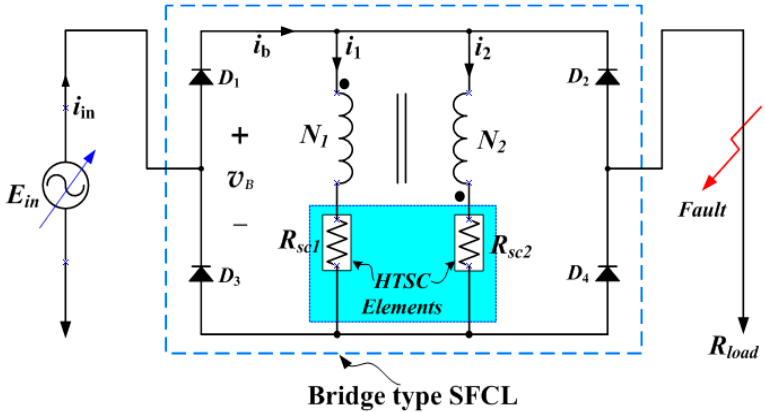
Figure 1. Schematic configuration of bridge type superconducting fault current limiter (SFCL) with simultaneous quench using flux-coupling.